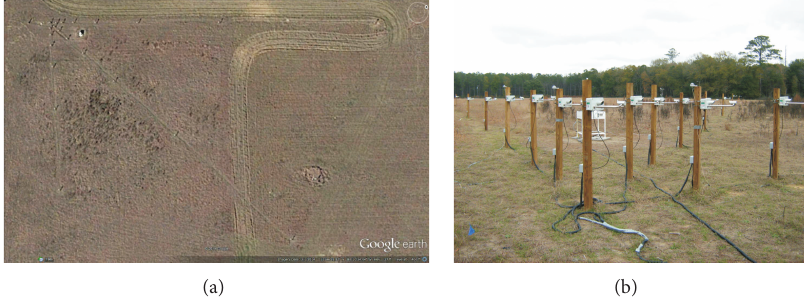
Figure 2: Pictures of the disdrometer array. (a) shows an overhead view of the site (as of March 1, 2014). The shadows of the LPMs can be identified by looking closely. The picture is aligned to replicate the general geometrical alignment shown in Figure 1; detector “A” is in the upper-left. The white object in the center of the box formed by detectors K, L, S, and T is a 2-dimensional video disdrometer (not used in this study). (b) displays part of the array from ground level. The first detector in the foreground is detector “A,” with the 2-dimensional video disdrometer visible in the background. All detectors are mounted nominally 1.75 meters off of the ground.